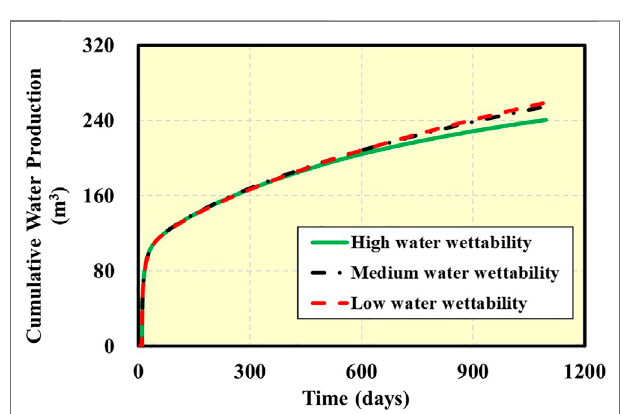
FIGURE 11 | Changing curves of the cumulative water production after 10-day shut-in and 3-year production for different reservoir wettability degrees.